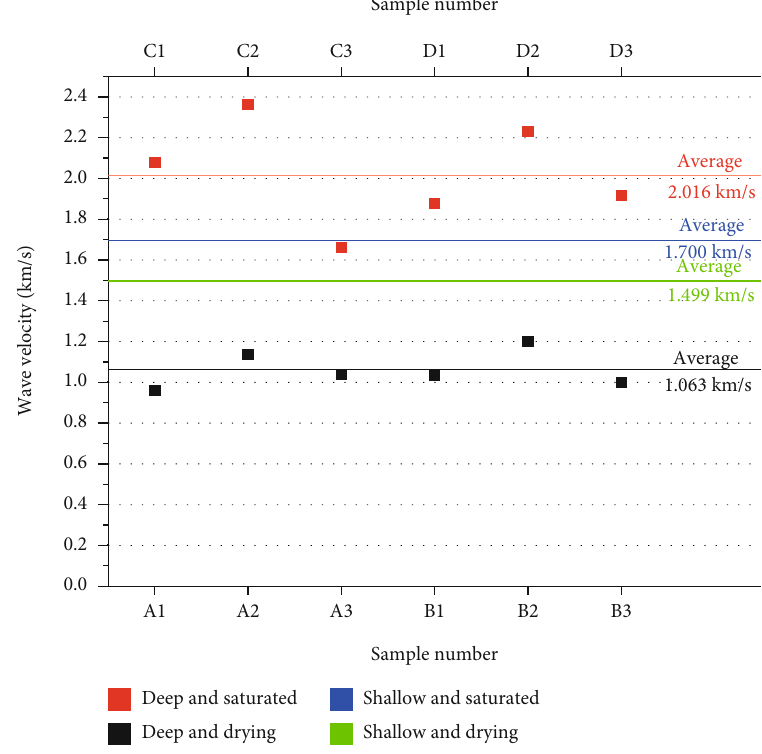
Figure 6: The wave velocity result of coal